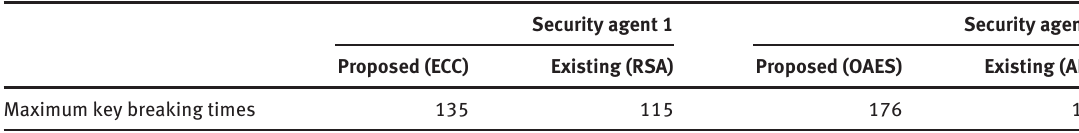
Table 5: Comparative Analysis of Key Breaking Time.